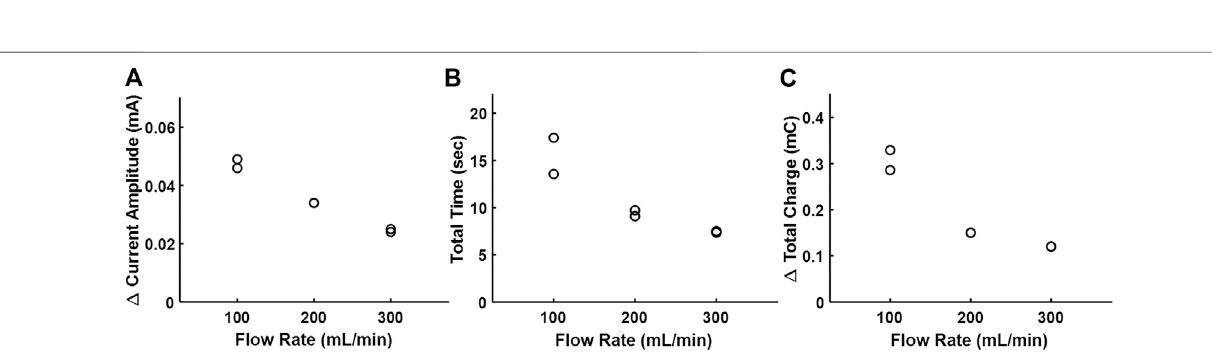
Frontiers in Chemistry |